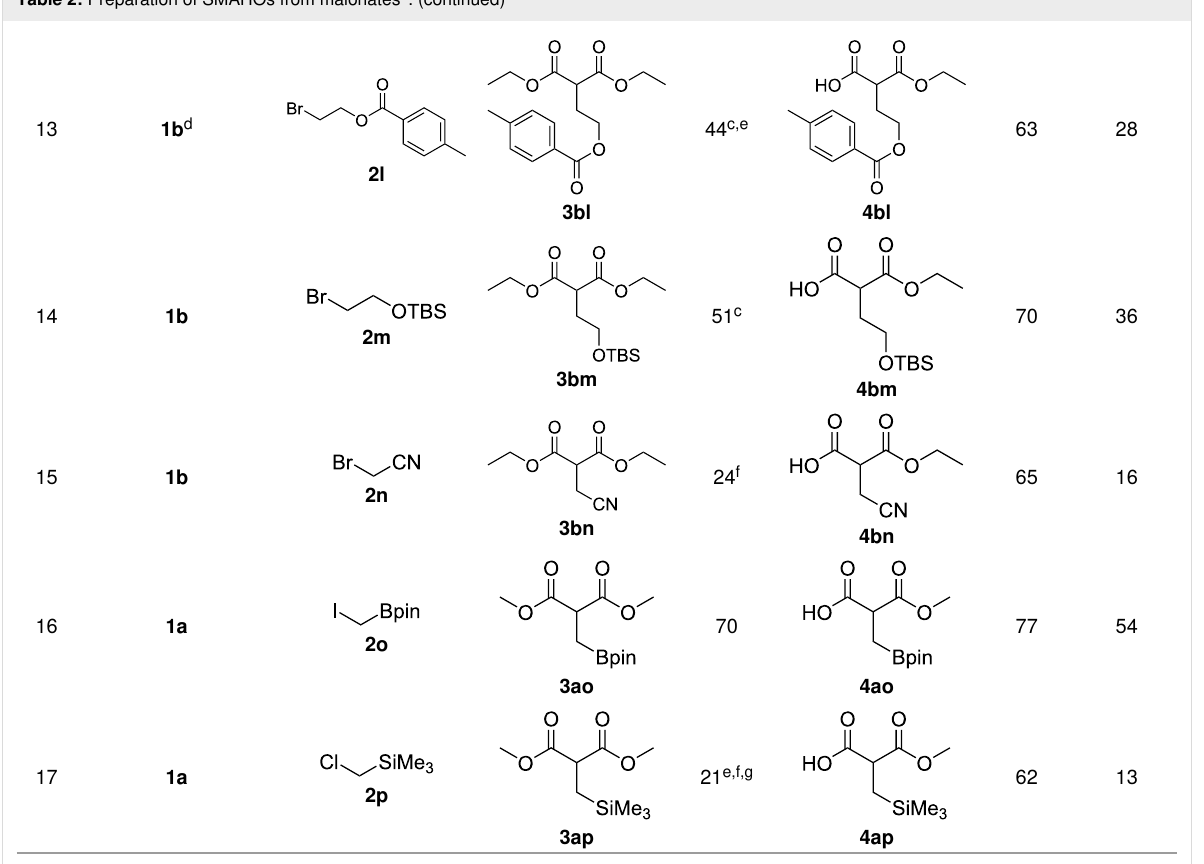
a Yields of isolated products. Step 1: 1 (1.1 equiv), 2 (5–50 mmol), NaH (1.0 equiv), DMF ( c = 0.5–1.0 M), 0 °C to rt, 2 h. Step 2: KOH (1.0–1.2 equiv), R 1